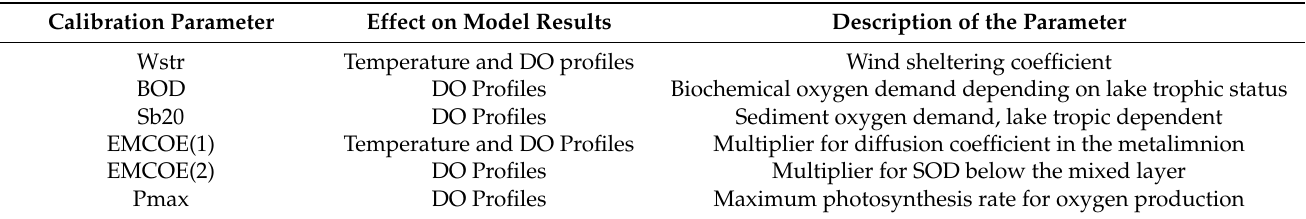
Table 2. Calibration parameters for hourly and daily MINLAKE models [35].